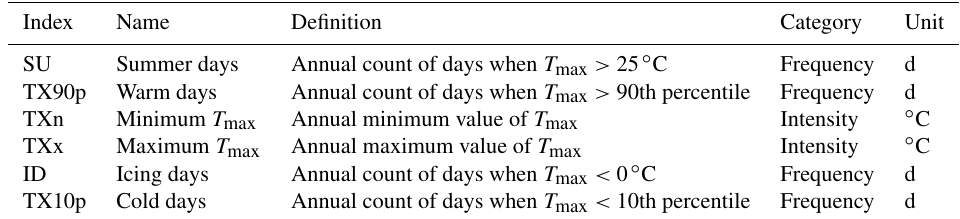
Figure 3. Flow chart of T max correction. Table 2. Definition of extreme temperature